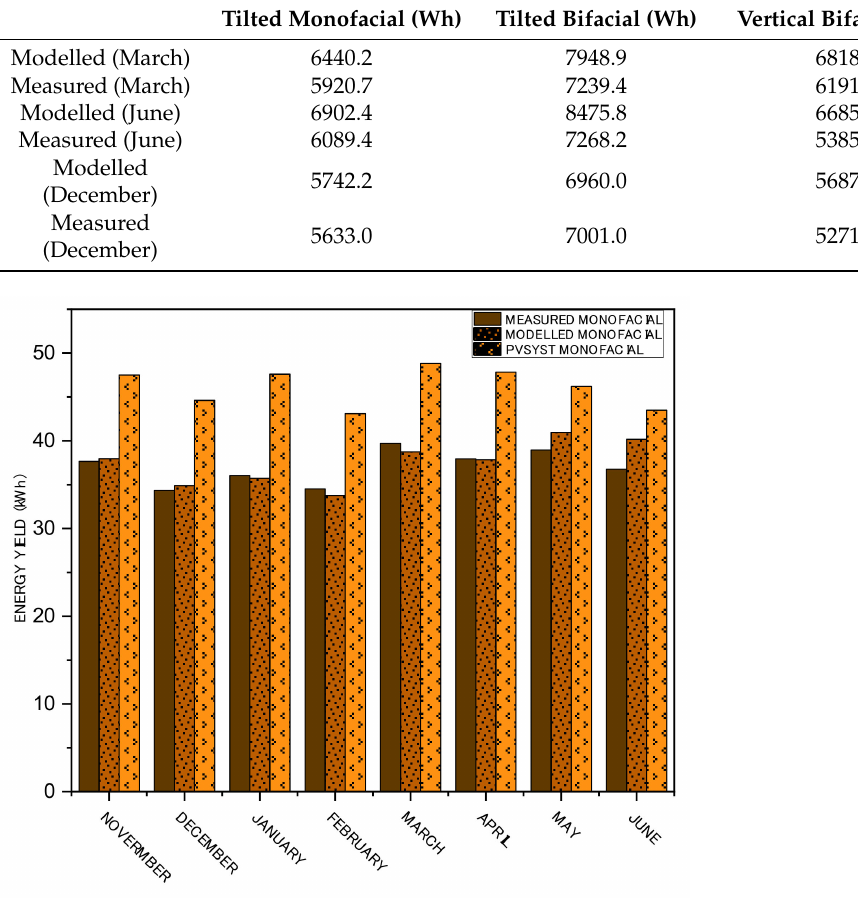
Figure 3. Measured, modelled, and PVsyst monthly energy yield of the tilted monofacial PV system.